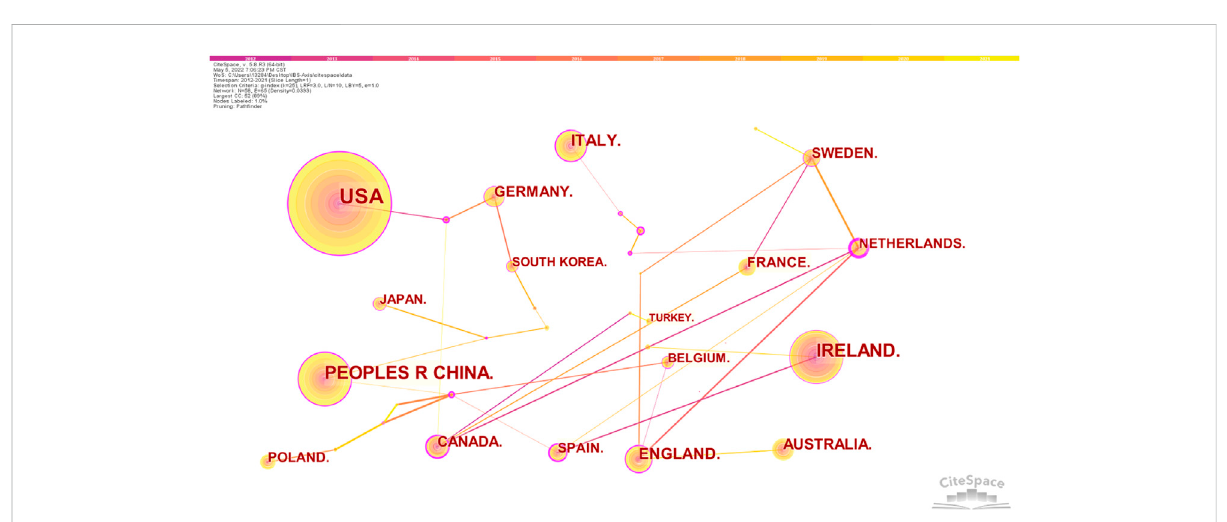
FIGURE 3 Country/region collaboration network of research on IBS and the brain – gut